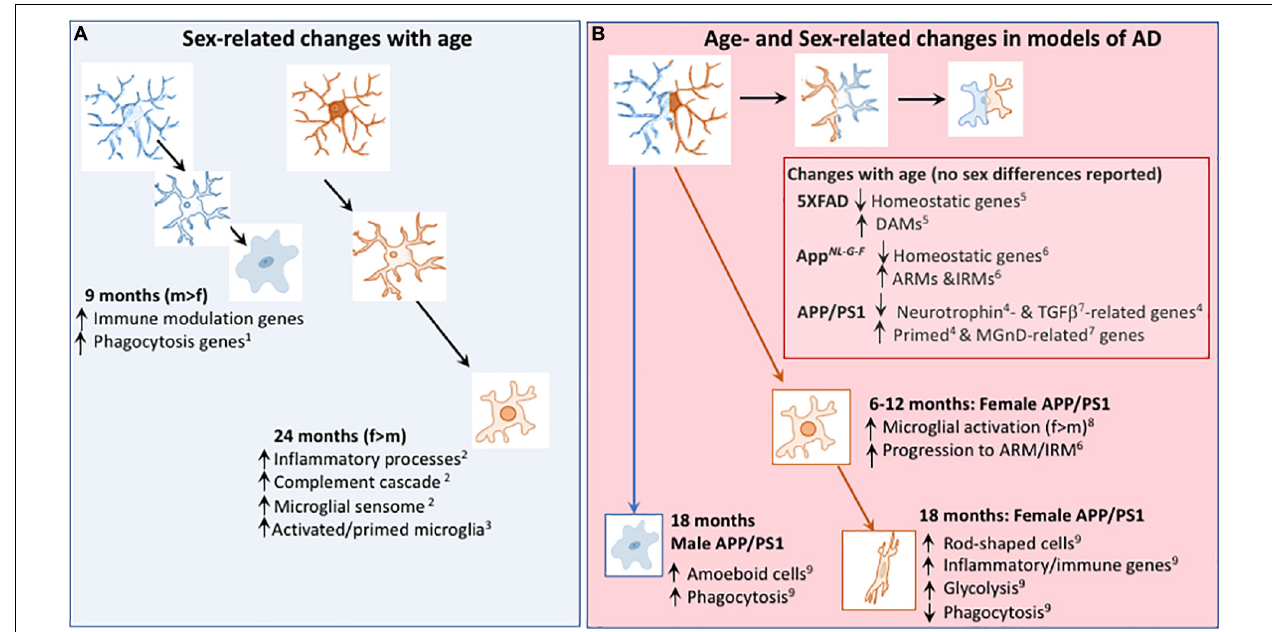
FIGURE 2 | Age- and Sex-related changes in microglia in age and models of AD. (A) Microglial phenotype changes with age in a sex-dependent manner. Transcriptomic analysis revealed that genes indicative of immune modulation and phagocytic function are upregulated in 9-month-old male, compared with female, mice 1 . At 24 months of age, transcriptomic analysis indicates that microglia from female mice exhibit greater upregulation of genes including those indicative of inflammatory processes and primed microglia than microglia from male mice 1 , 3 . (B) Changes in the microglial transcriptome that occur with age in models of AD include downregulation of genes that are described as homeostatic 5 , 6 and genes that modulate neurotrophins 4 and TGF β 7 , together with upregulation of genes that are described as DAMs 5 , ARMs 6 , IRMs 6 , primed 4 and MGnD-related 7 ; sex-related changes were not reported in these studies. From 6 months of age, there was evidence of a change in expression of microglial markers 8 and a faster transition toward the microglial genotype described as ARMs/IRMs in female APP/PS1 mice compared with males 6 . Microglia from 18 month-old female APP/PS1 mice were glycolytic and exhibited upregulation of genes that are indicative of inflammatory/immune processes 9 whereas amoeboid and phagocytic microglia were increased in 18 month-old male APP/PS1 mice compared with females 9 . DAM, disease-associated microglia; ARM, Activated response microglia, IRM, interferon response microglia; MGnD, microglial neurodegenerative phenotype. References: 1 Kodama et al., 2020; 2 Mangold et al., 2017; 3 Kang et al., 2018; 4 Holtman et al., 2015; 5 Keren-Shaul et al., 2017; 6 Sala Frigerio et al., 2019; 7 Krasemann et al., 2017; 8 Gallagher et al., 2013; 9 Guillot-Sestier et al.,